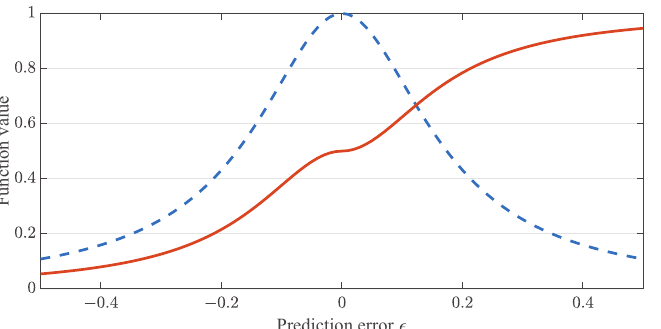
Figure 1. Credibility and membership functions associated with forecast error percentage of spot